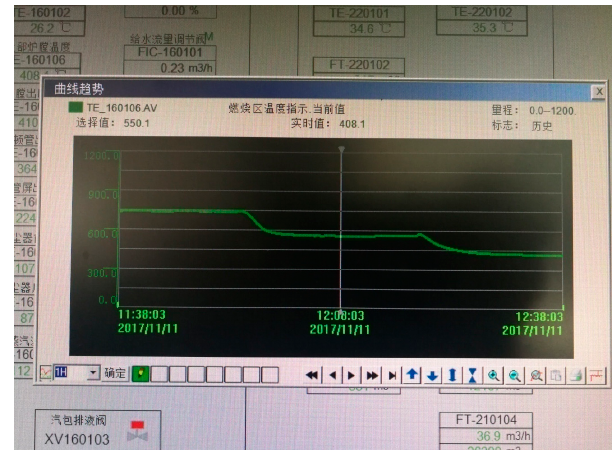
Figure 7. Example of measuring point curve.